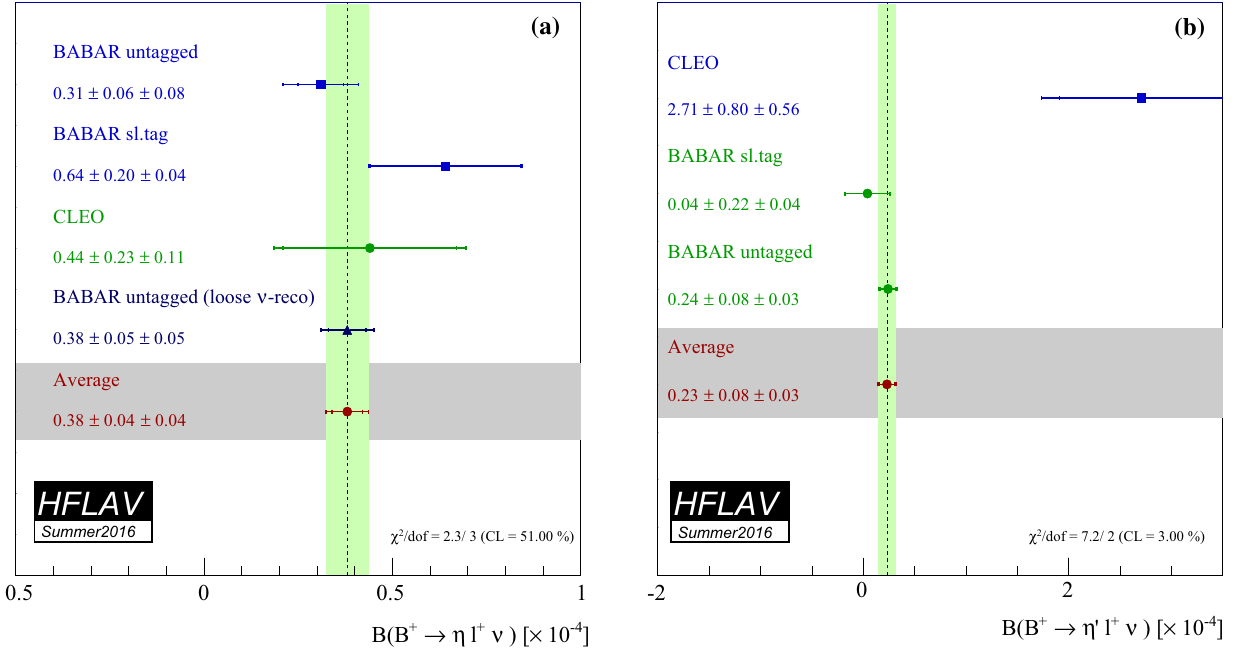
Fig. 62 a Summary ofexclusive determinationsof B ( B + → η(cid:12) + ν) andtheiraverage. b Summary ofexclusive determinationsof B ( B + → η (cid:7) (cid:12) + ν) and their average